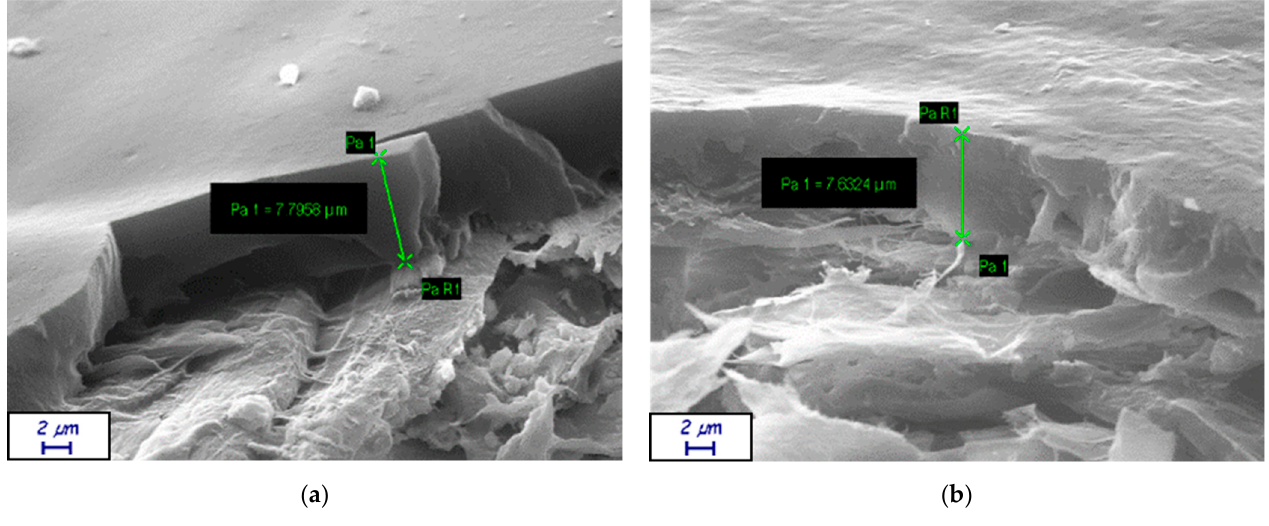
The samples were analyzed at the SEM to ensure coherence between the calculated film thickness and the actual value. Figure A5 shows two representative micrographs.